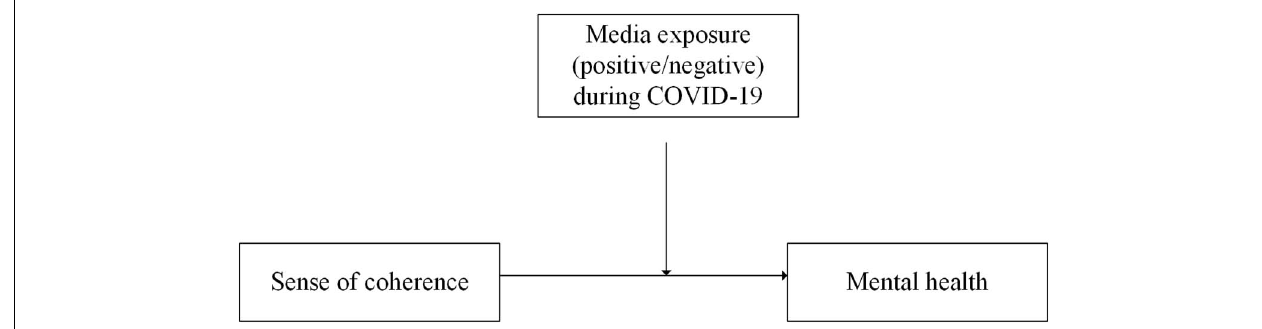
FIGURE 1 | Hypothetical model of the moderating effect for the relationship between sense of coherence (SOC) and mental health.